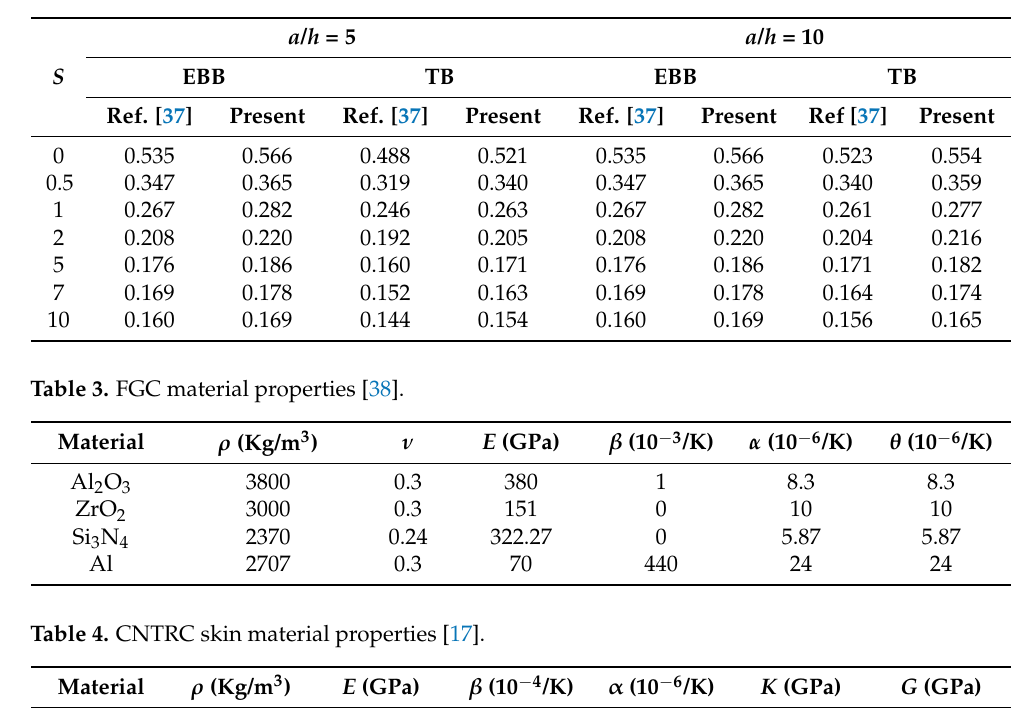
Table 2. Comparison of the dimensionless critical buckling load of FGM beams as computed in the current study with respect to the literature [37] ( × 100).